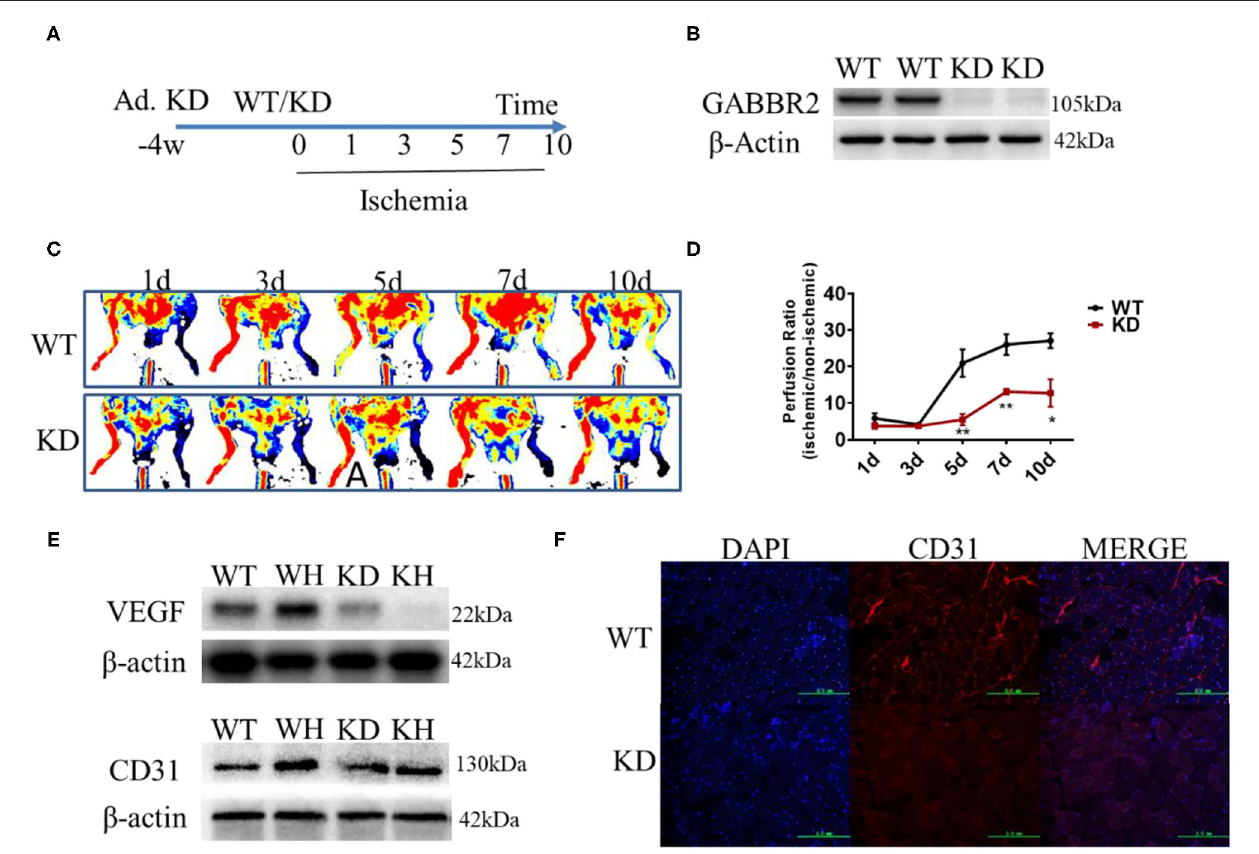
FIGURE 3 | Effect of gamma-aminobutyric acid type B receptor subunit 2 (GABBR2) knockdown on blood recovery of the ischemic hindlimb in mice. (A) Protocol of adenovirus injection and the establishment of mouse hindlimb ischemia. (B) Knockdown efficiency of GABBR2 in mouse hindlimb. (C) Blood recovery of mouse hindlimb imaged by laser Doppler at different time points. (D) Statistical analysis of the blood perfusion ratio (ischemic/non-ischemic hindlimb). (E) Expression changes of VEGF and CD31 post-ischemia in wild-type (WT) and GABBR2-downregulated hindlimbs. (F) Immunofluorescent staining of CD31 in WT and GABBR2-downregulated ischemic hindlimbs. Bar , 200 µ m. * p < 0.05; ** p <